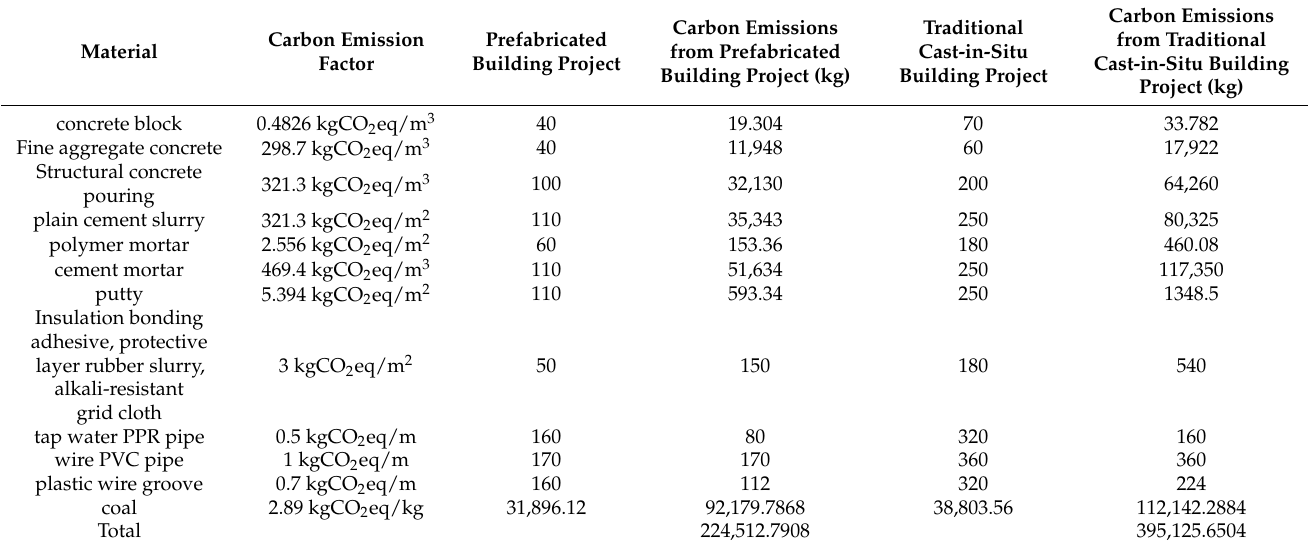
Table 2. Differences in carbon emissions during the use stage of the